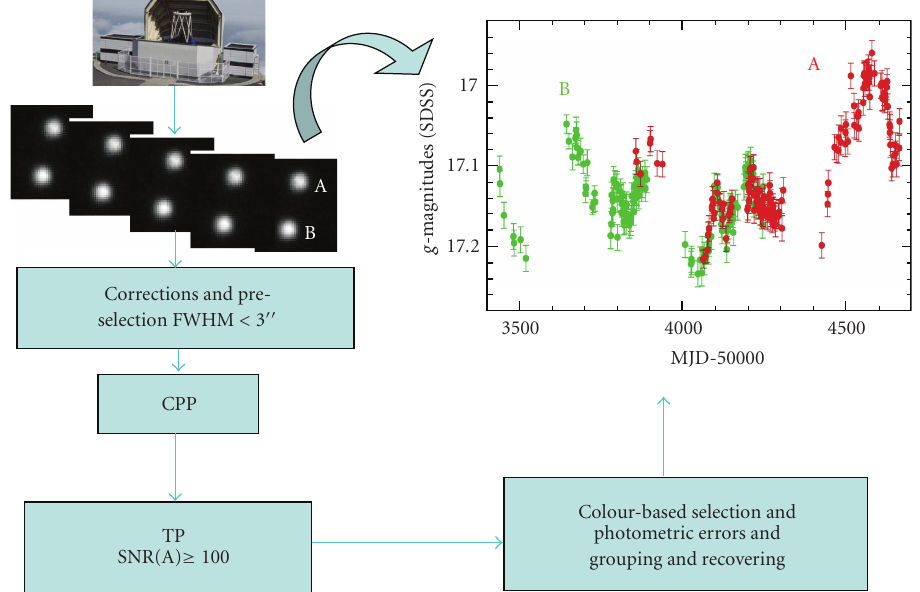
Figure 1: Photometric scheme for QSO 0957 + 561: from LRT frames in the g band to SDSS magnitudes of both images (see main text for